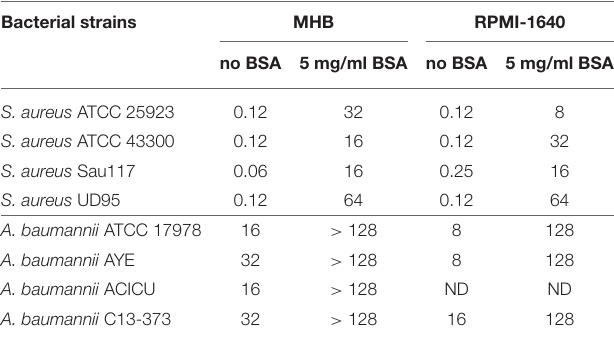
TABLE 2 | Effect of BSA on the MIC ( µ M) of GaPPIX for S. aureus and A. baumannii . Bacterial strains MHB